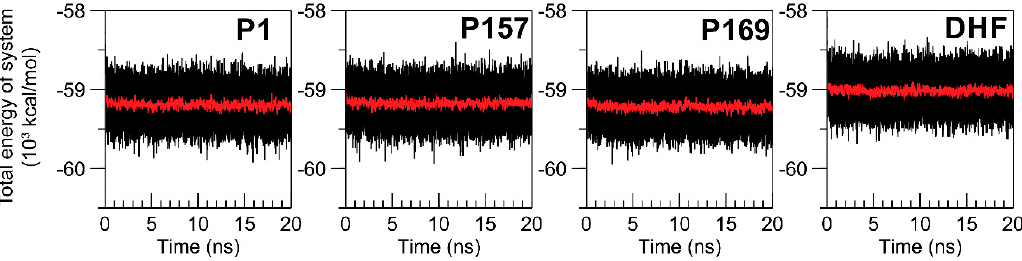
Figure 2. Total energy (E total ) of ternary M. tuberculosis DHFR (mtbDHFR)-NADPH complexed with P1, P157, P169, and DHF during 20 ns of molecular dynamics (MD) simulations (black lines) and the average values of E total in each 20-ps time interval during the 20-ns MD simulations (red lines).